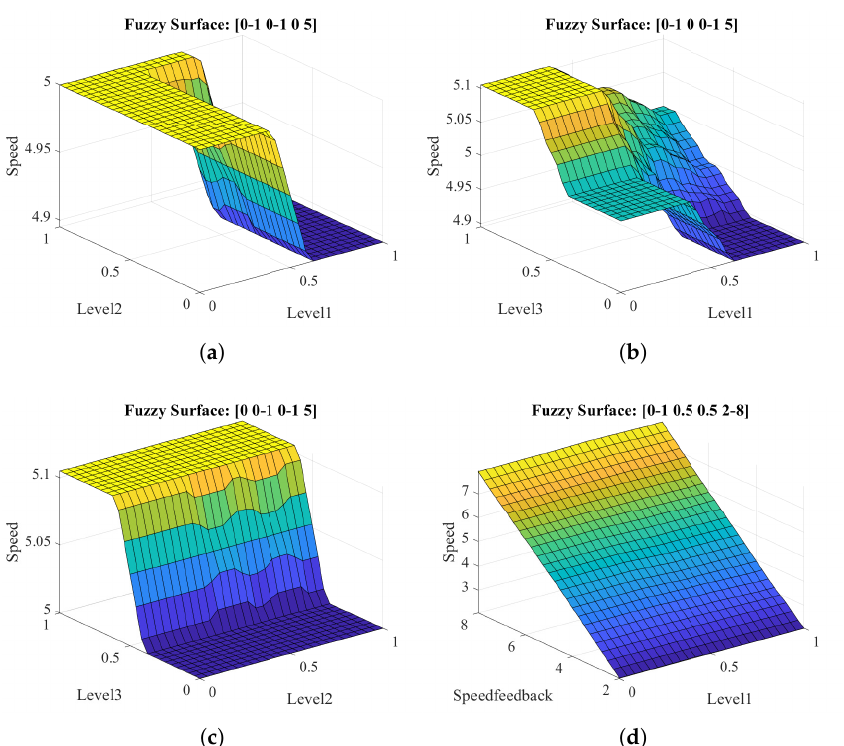
Figure 4. Fuzzy inference model output surface for different input combinations. ( a ) Inputs for levels 1 and 2. ( b ) Inputs for levels 1 and 3. ( c ) Inputs for levels 2 and 3. ( d ) Inputs for level 1 and velocity feedback. Each plot presents the input values in the following order: lvl 1 , lvl 2 , lvl 3 , and ˙ x ref ( n − 1 )